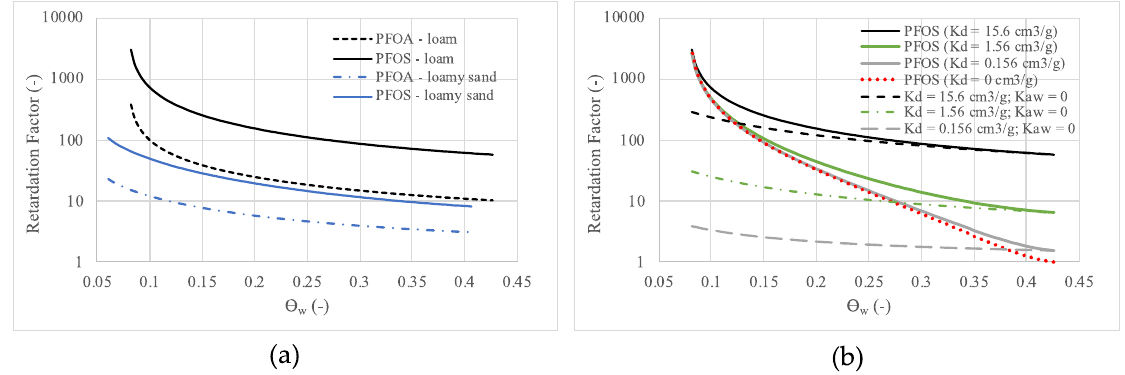
Figure 8. Calculated retardation factors for PFAS: ( a ) PFOA and PFOS retardation in the loam and loamy sand, ( b ) trends in PFOS retardation for the loam soil as K d and k aw vary ( k aw = 0 cases are without AWI adsorption).